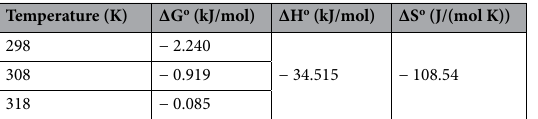
Table 4. Thermodynamic parameters for the adsorption of CV dye by Zn–Mg–Al/LDH.